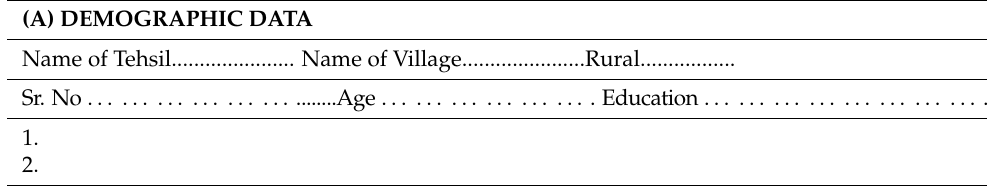
Table 2. Questionnaire for Conducting the Ethnomedicinal